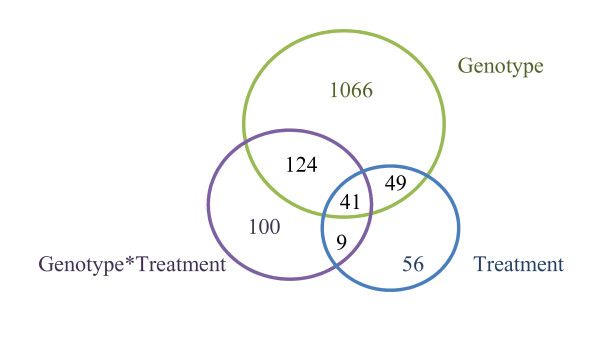
Differentially expressed contigs. Venn diagram indicating the number of differentially expressed contigs showing a G, T and/or GxT effect, for the 14,460 contigs analysed.